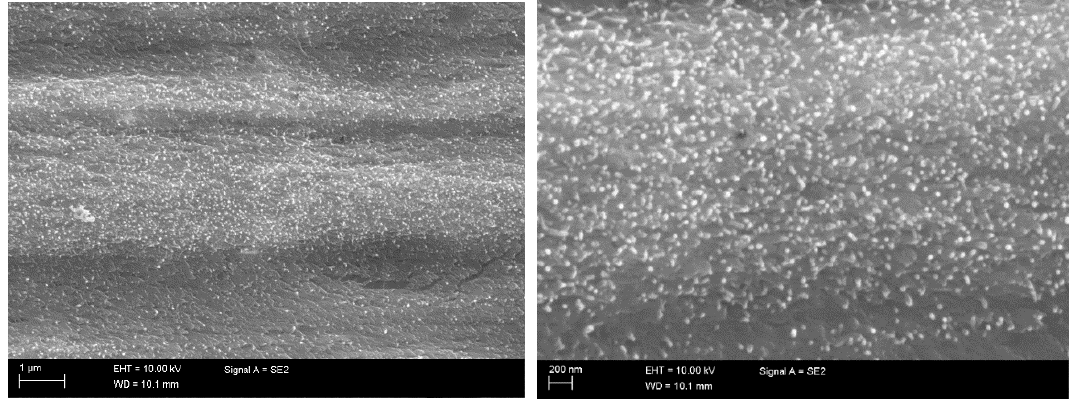
Figure 5. SEM imaging of the nanocomposite film (Triton X-100, 500 kJ/g) cross-section when embedded in epoxy: Left side: overall structure; Right side: magnification in the center of the film.